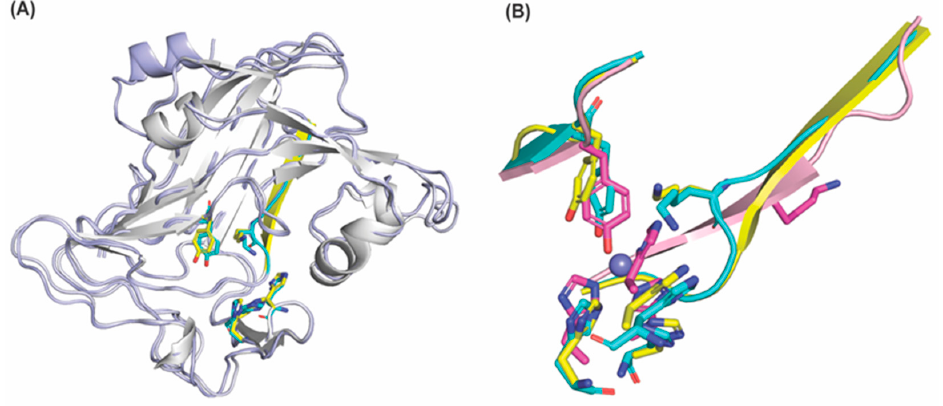
Figure 5. Overlay of the amine oxidase domains of LOX and LOXL2. ( A ) Overlay of AlphaFold 2–predicted human LOX (peptide backbone: in white; the LTQ precursors in yellow, His292-X-His294-X-His296: in yellow) and mouse LOXL2 (peptide backbone: in light blue; the LTQ precursors: in cyan, His628, His630, His632: in cyan). The major difference is the secondary structure of the heptapeptide (Val315–Ala321 in human LOX: β –sheet in yellow and Val650–Ala656 in mouse LOXL2: loop in cyan). In both structures, the precursor Lys residues (Lys320 in human LOX and Lys655 in mouse LOXL2) are within 4.0Å and 4.7Å from the C2 position of the precursor Tyr residues (Tyr355 in human LOX and Tyr691 in mouse LOXL2), respectively. ( B ) Overlay of the precursor Lys–containing heptapeptides, (PDB: 5ze3, in light pink, residues are in magenta, Zn 2+ is in slate), AlphaFold 2–prediced human LOX (in yellow) and AlphaFold2–predicted mouse LOXL2 (in